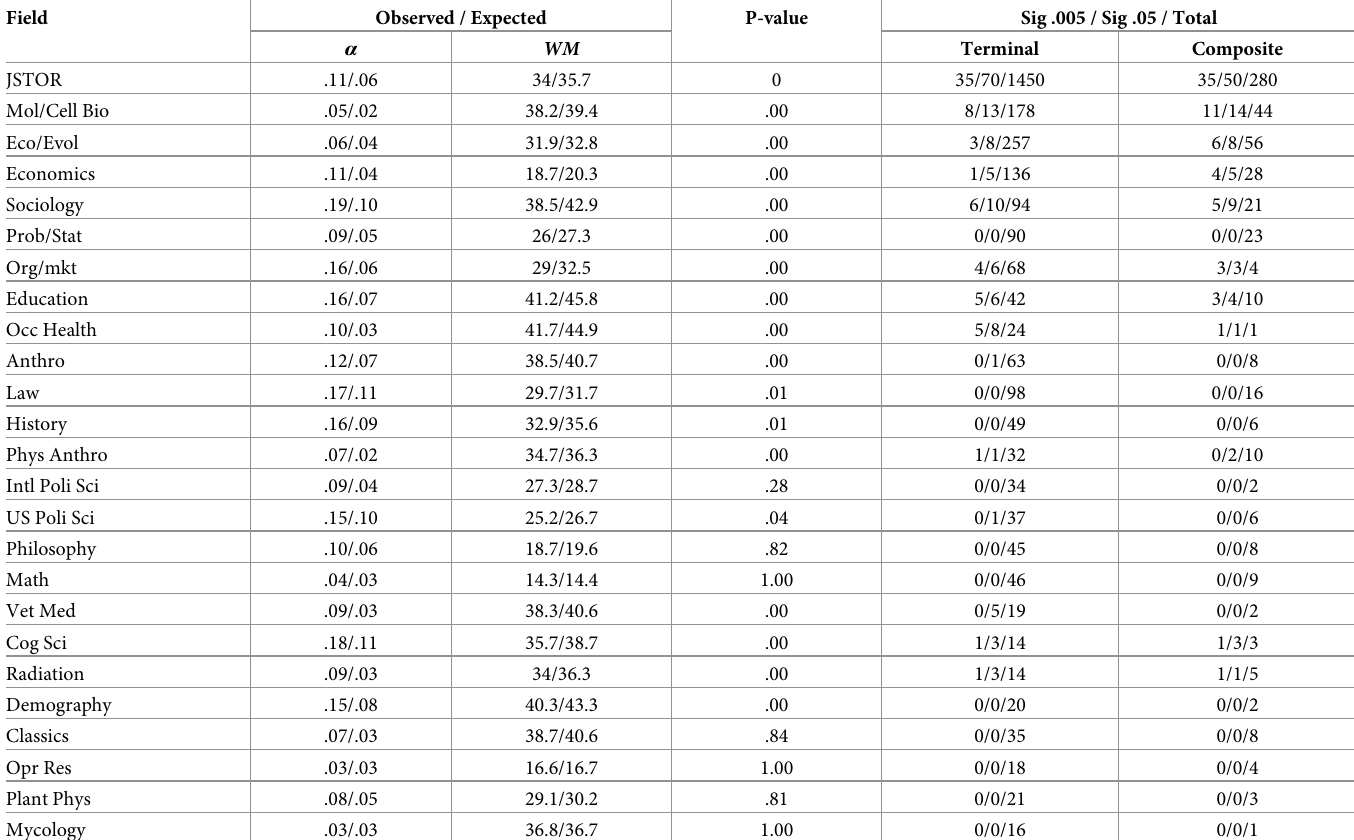
Table 1. Main results. Results for the JSTOR corpus and each top-level field, sorted largest to smallest (top to bottom) by number of authorships. The α column gives the observed value and expected value under no behavioral homophily; the WM column gives the number of heterophilous documents corresponding to the observed and expected α . The “P-value” column gives the Benjamini-Yekutieli adjusted p-value for the top-level field; “Terminal” and “Composite” columns give the counts of terminal and composite fields are which significant at the .005 level / significant at the .05 level /